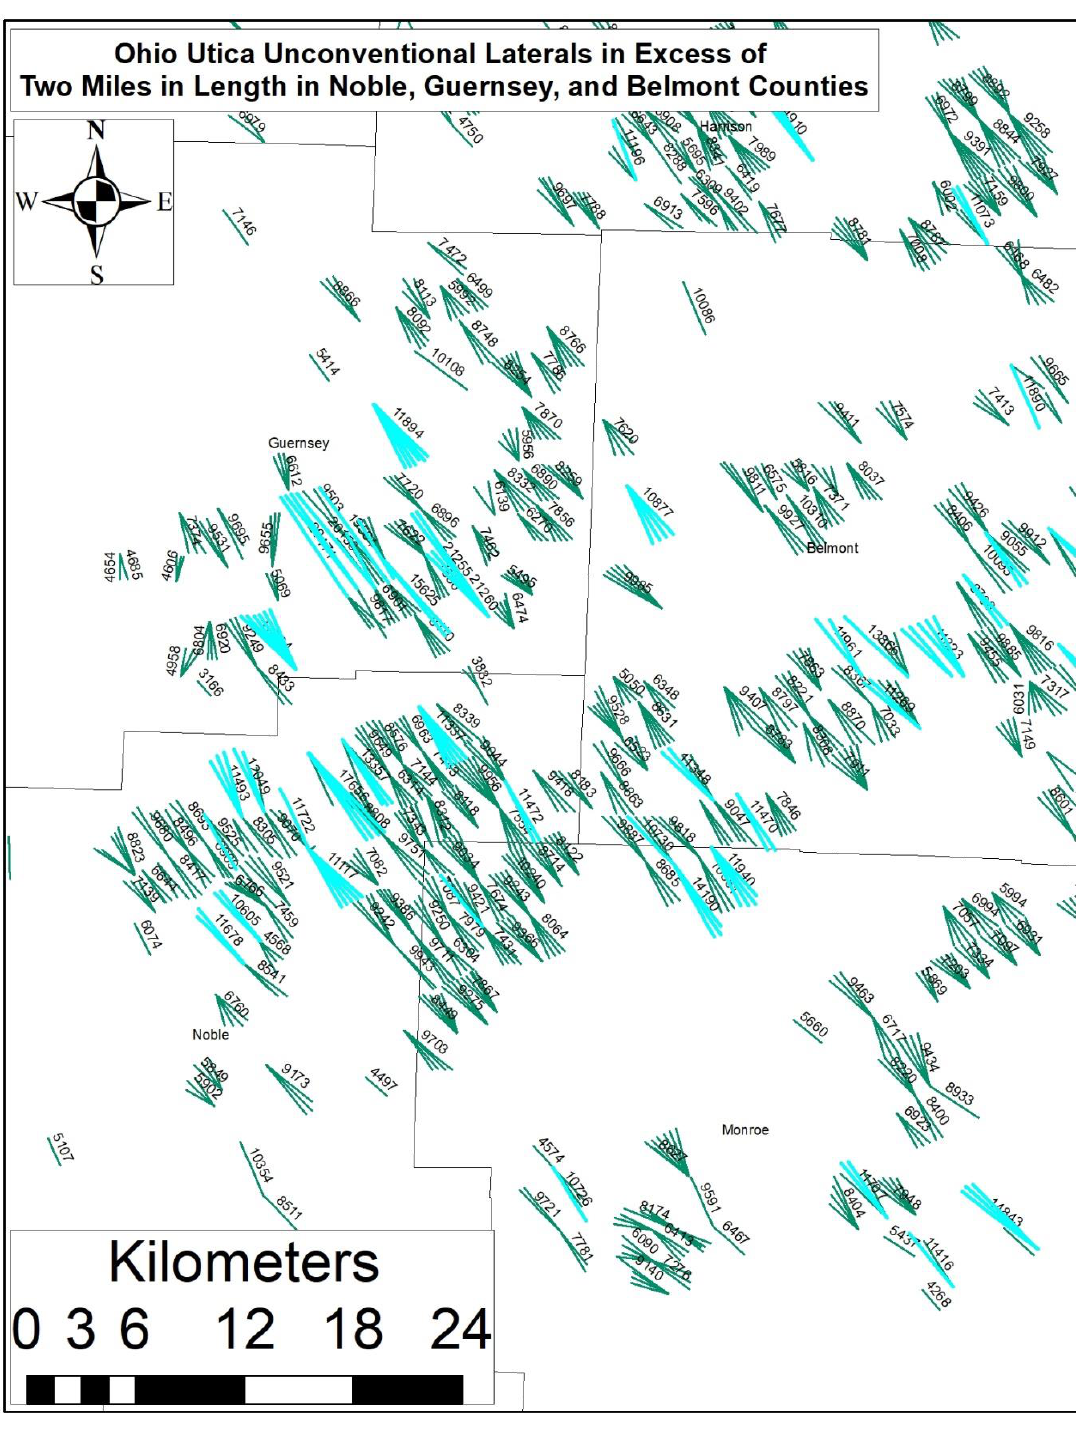
Figure 4. Examples of hydraulic fracturing lateral length in north-eastern Noble County, Ohio, including highlighted pads where laterals exceed 2 miles in length.